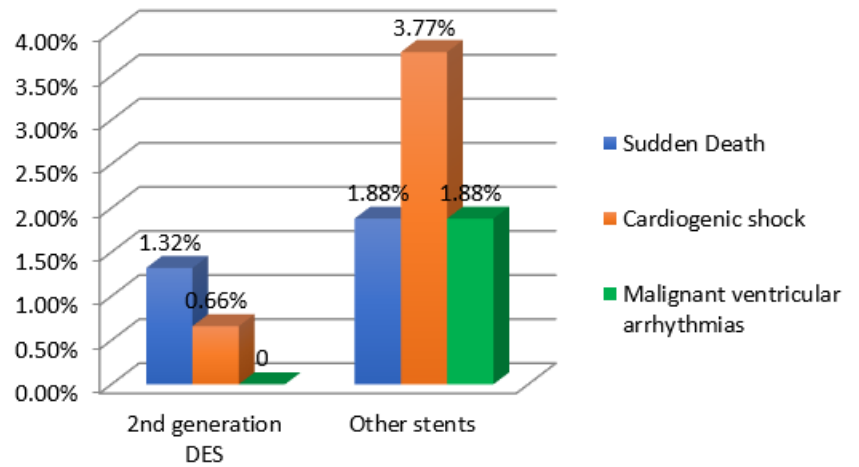
Figure 1. Leading causes of cardiac deaths in patients according to stent type inserted.